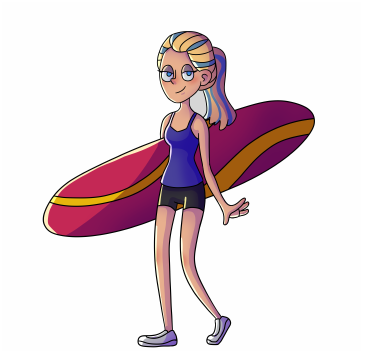
Figure 11. The character of the fifth phase - Ema.